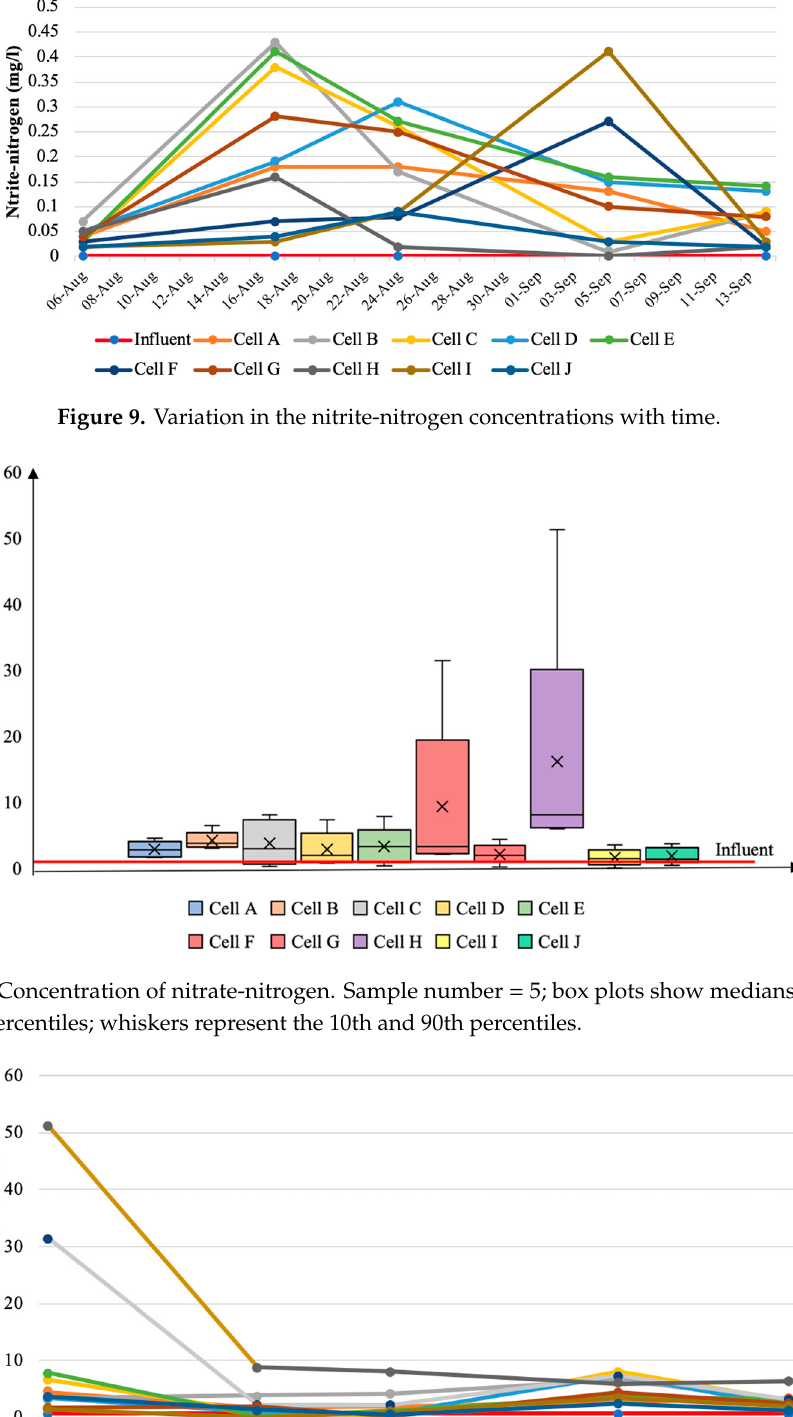
Figure 10. Concentration of nitrate-nitrogen. Sample number = 5; box plots show medians and 25th and 75th percentiles; whiskers represent the 10th and 90th percentiles.